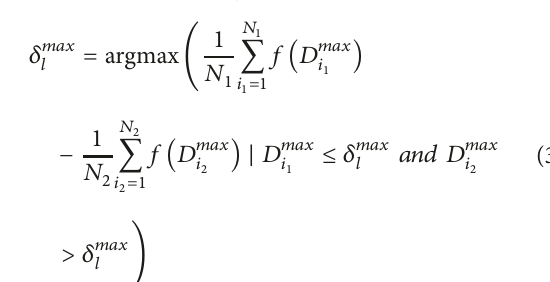
Figure 5: Relationship between 𝐷 𝑚𝑎𝑥 𝑖 and V 𝑟𝑒𝑎𝑟 𝑖 at the Xianxia- Jianhe intersection. When 𝛿 𝑚𝑎𝑥 𝑙 = 3.27𝑚 , the difference between the average speed of rear vehicles when 𝐷 𝑚𝑎𝑥 𝑖 ≥ 3.27𝑚 and 𝐷 𝑚𝑎𝑥 𝑖 < 3.27𝑚 reaches the